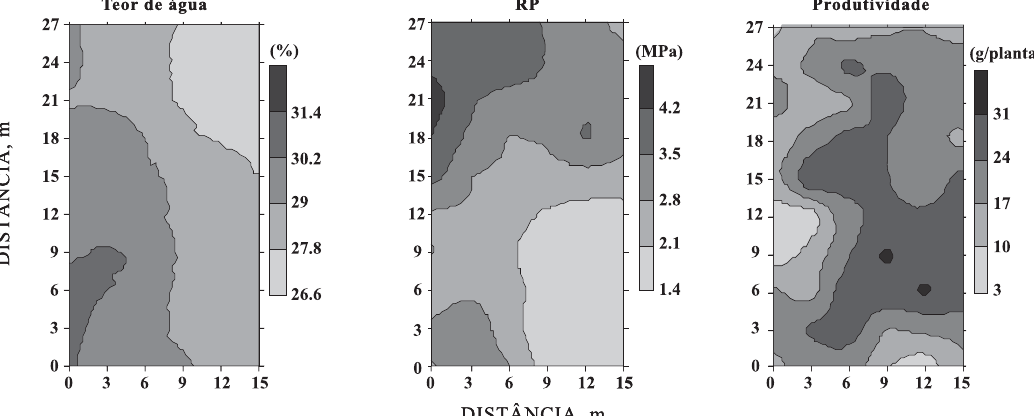
Figura 3. Mapa da distribuição espacial de teor de água do solo, resistência do solo ao penetrômetro (RP) e produtividade do feijoeiro sob sistema semeadura direta – safra de